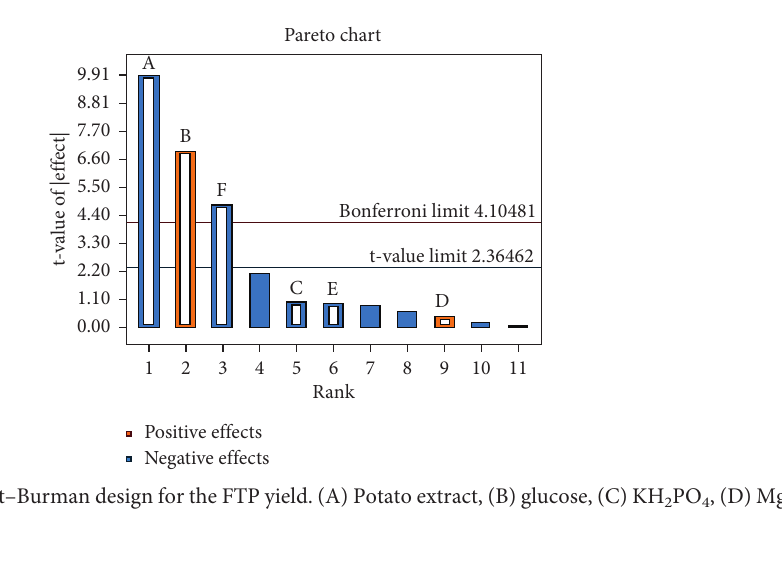
· 7H 2 PO 4 , (D) MgSO 4 2 O, (E)